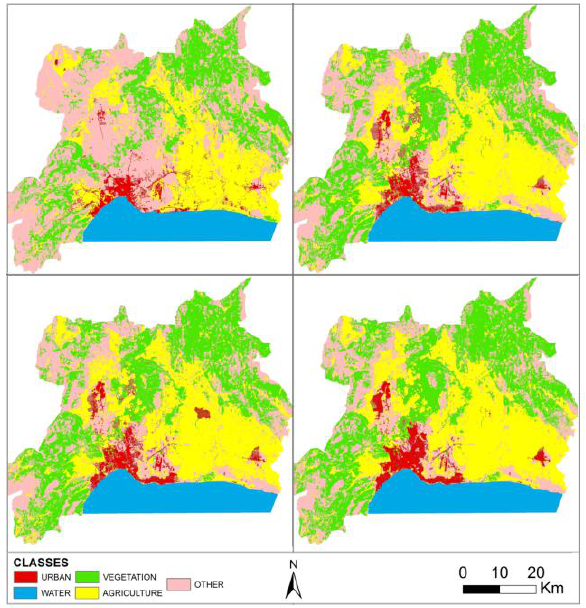
Figure 4. Simulation results; (a) 2015, (b) 2030, (c) 2045